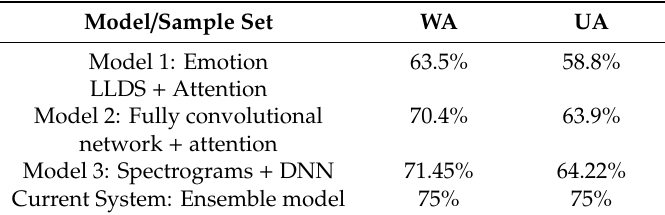
Table 7. Comparison of ensemble model with other models.